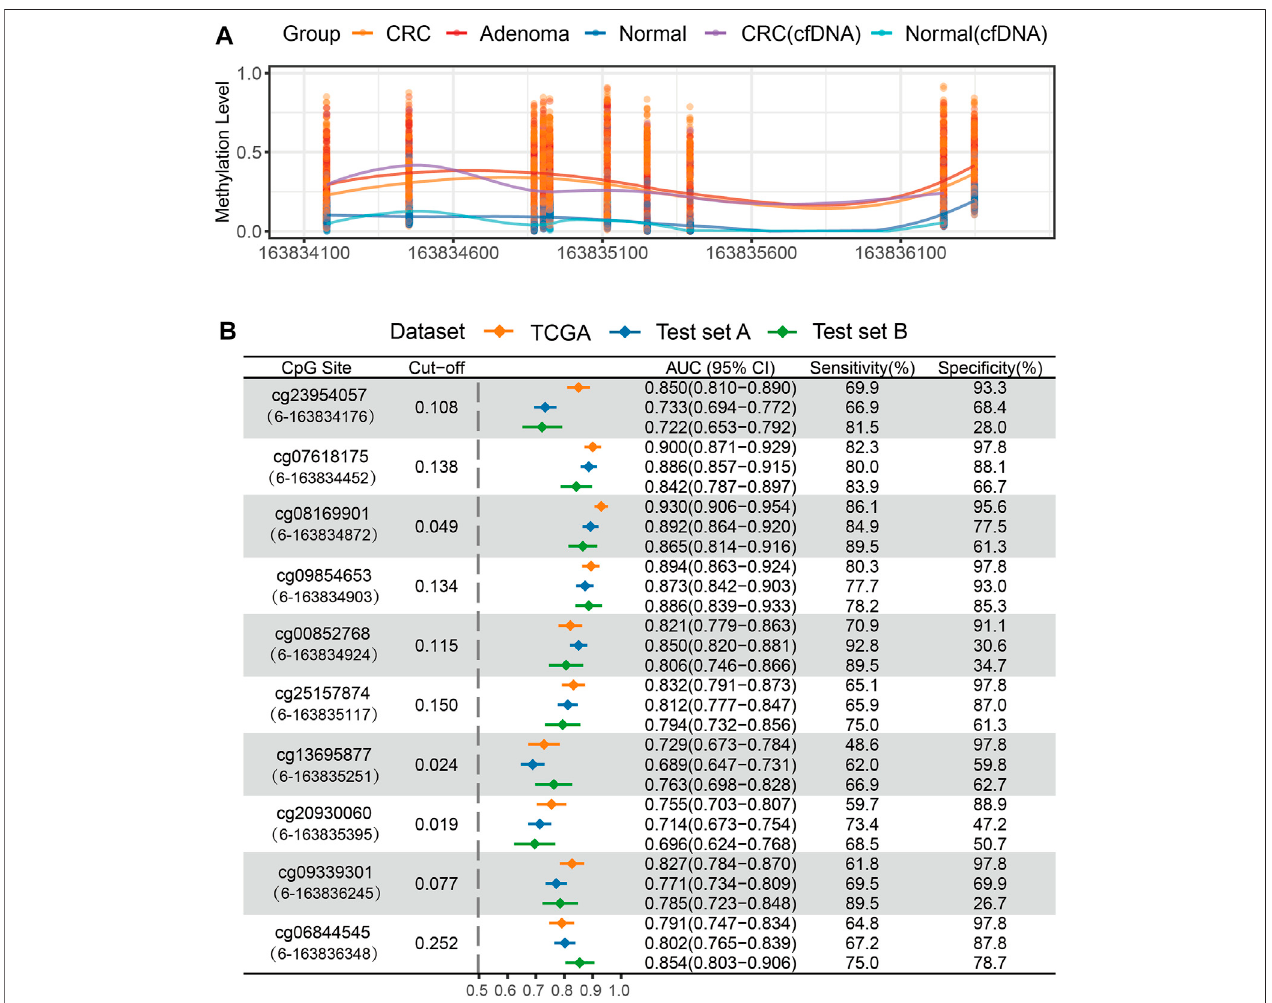
FIGURE3| Methylationanalysisof QKI promoterinthetestset. (A) Themethylationlevelof10CpGsitesofthe QKI promoterinthetestset. (B) ROCcurveanalysis of 10 CpG sites of the QKI promoter for discriminating CRC or adenoma tissues from normal tissues in the discovery and test dataset. The content in brackets denotes the “ chromosome ” - “ coordinate ” of each CpG